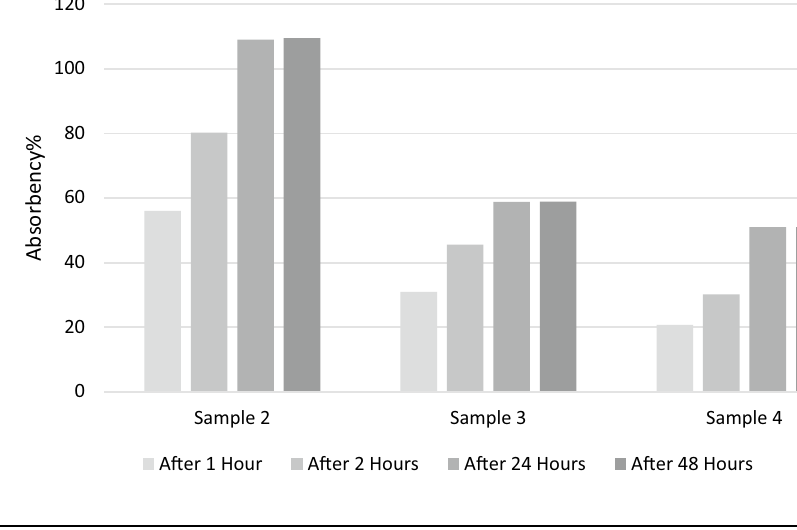
Table 4 ANOVA of the Water Absorption behavior of different